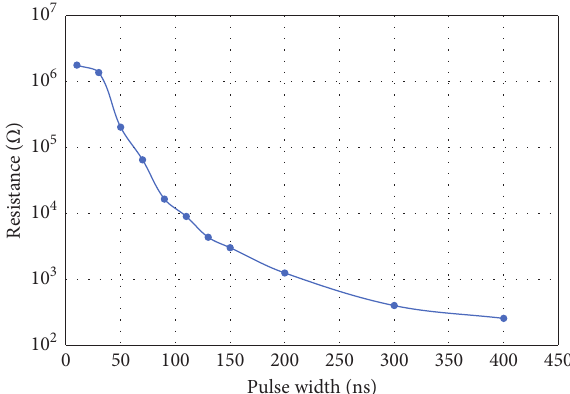
Figure 8: Pulse width vs. resistance curve of simulation